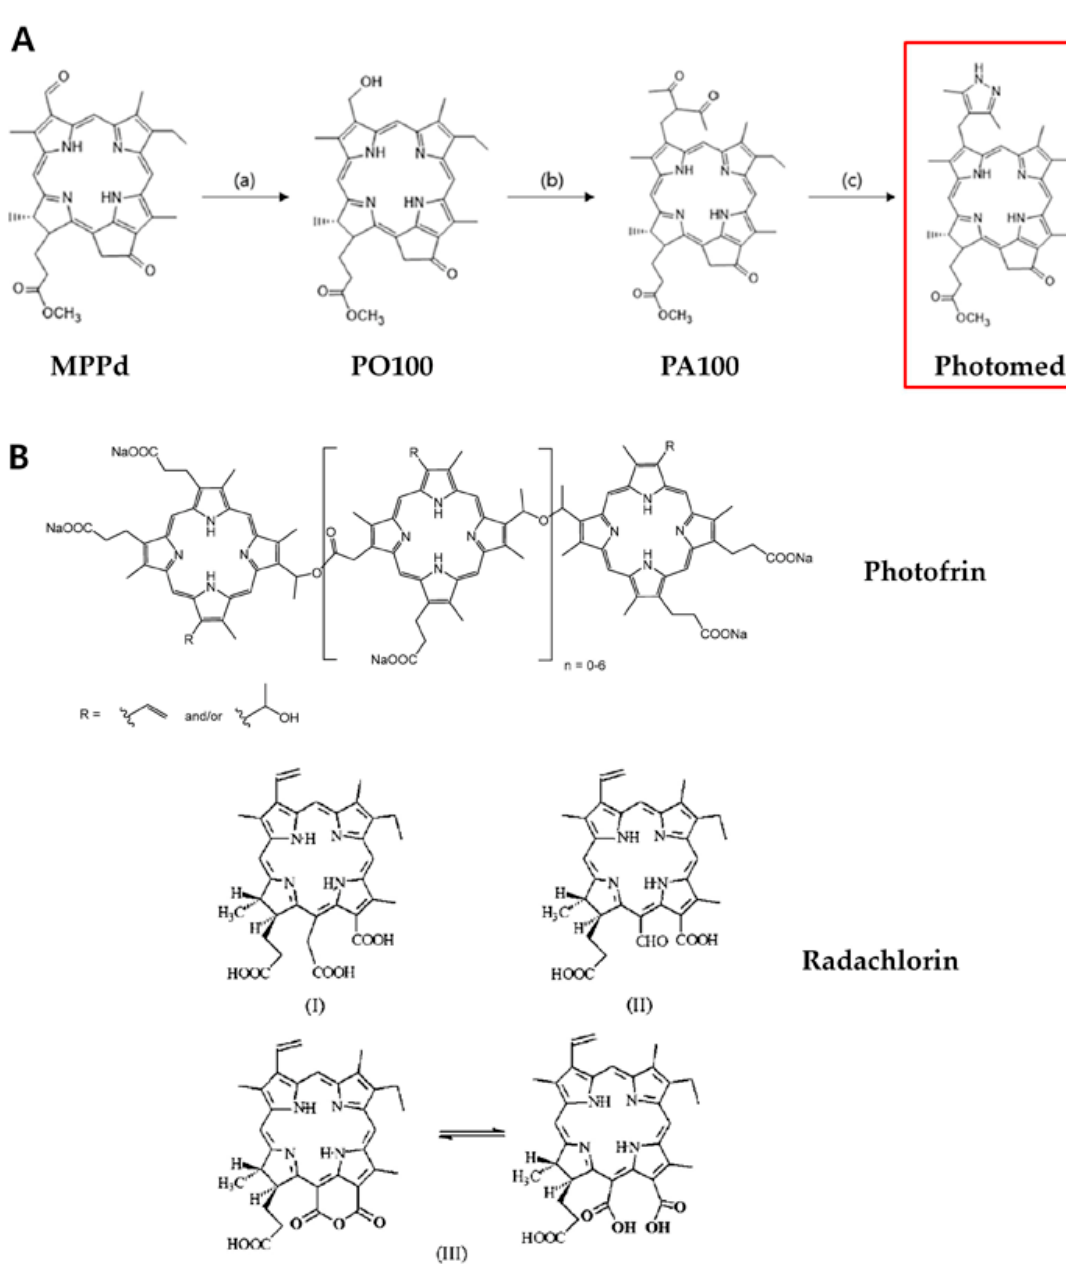
Figure 1. ( A ) Synthesis of Photomed. (a) t -BuNH 2 BH 3 , CH 2 Cl 2 , for 12 h, at room temperature, under nitrogen. (b) Acetyl acetone, Zn(OAc) 2 , for 1 h at 60 °C, for 1.5 h at 110 °C, 6 N HCl for 20 min. (c) Hydrazine hydrate, EtOH, CH 2 Cl 2 , for 2 h, at room temperature. ( B ) Structures of Photofrin [24] and Radachlorin: chlorin e6 (I), chlorin p6 (II) and purpurin (III) [23].